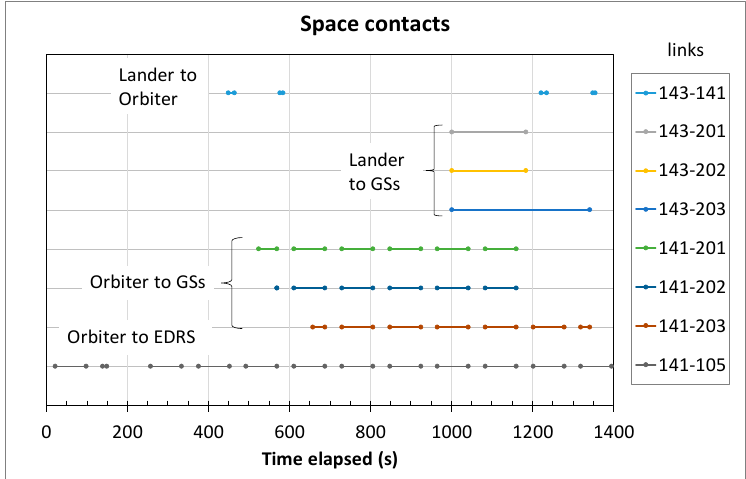
Figure 6. Excerpt of the contact plan used in the experiments: intermittent contacts from Lander (143) and Orbiter (141) in top-down order. All contacts have been scaled down by a factor of 60 (seconds instead of minutes) with respect to the original contact plan.